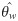
Summary of genomic data.Segments from outside to inside: P. vivax chromosomes with exonic regions shaded green; regions excluded from variant calling in this study; heatmap of θw^ in 10kb windows, high-diversity regions are darker and the maximum value is 0.0018; heatmap of π^ in 10kb windows; mean number of samples covered per base in 10kb windows.